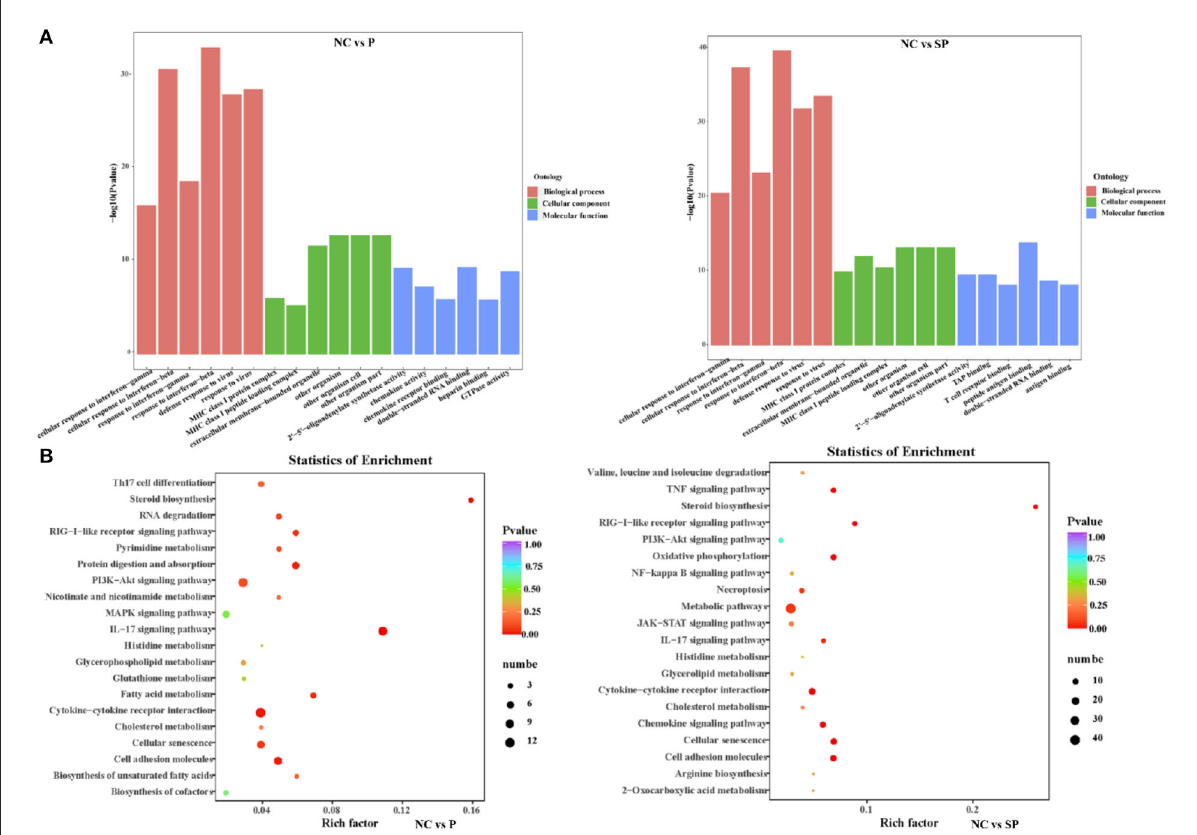
FIGURE2 Analysis of GO and KEGG enrichment. (A) GO functional annotation of the differentially expressed genes in different groups. (B) KEGG pathway enrichment of the differentially expressed genes in different